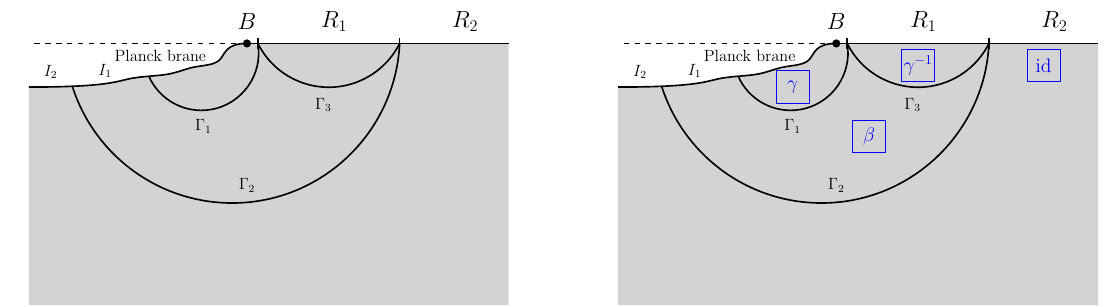
Figure 43 . Islands in the 3d picture. We show several options for extremal surfaces. On the r.h.s., an example of a corresponding tensor network is shown labeled by the permutations (this depends on what extremal surfaces correspond to each